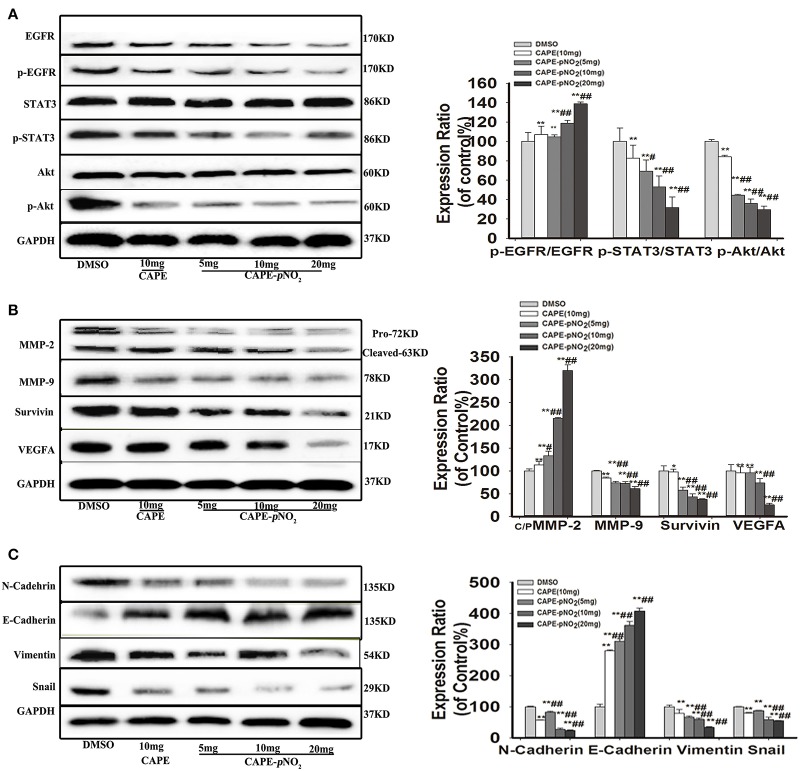
The EGFR/STAT3/Akt signaling pathway and EMT progression were suppressed by CAPE-pNO2 in tumors. The xenograft mice were treated with CAPE (10 mg/kg/day) and CAPE-pNO2 (5, 10, and 20 mg/kg/day) for 38 days. Western blot analysis was performed with related antibodies and quantified by densitometric analysis. (A) The protein expression levels of EGFR, p-EGFR, STAT3, p-STAT3, Akt, and p-Akt. (B) The protein expression levels of MMP-2, MMP-9, Survivin, and VEGFA. (C) EMT-related protein expression. The bar graphs show the relative protein expression levels. Values represent the mean ± SD from three independent experiments; *p < 0.05, **p < 0.01: CAPE and CAPE-pNO2 compared with DMSO group; #p < 0.05, ##p < 0.01: CAPE-pNO2 (5, 10 and 20 mg/kg) compared with CAPE (10 mg/kg).